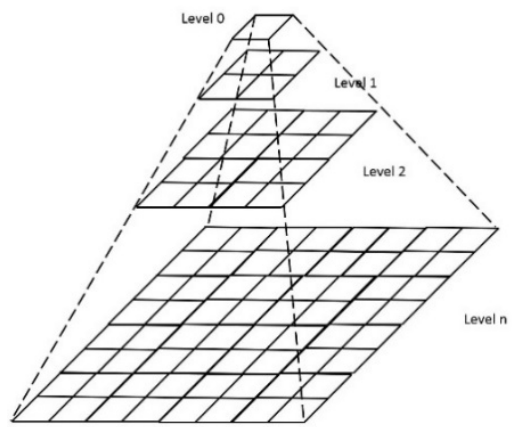
Figure 2. Illustration of the quadtree distribution diagram .